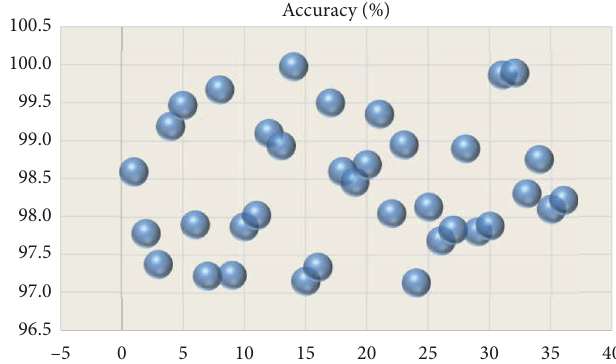
Figure 12: Statistical diagram of the accuracy of bolt positioning based on multieye vision industrial